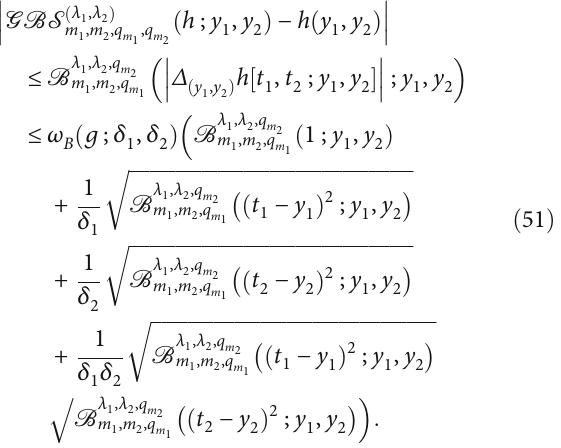
for m 1 = m 2 = 10, 20 and m 1 , m 2